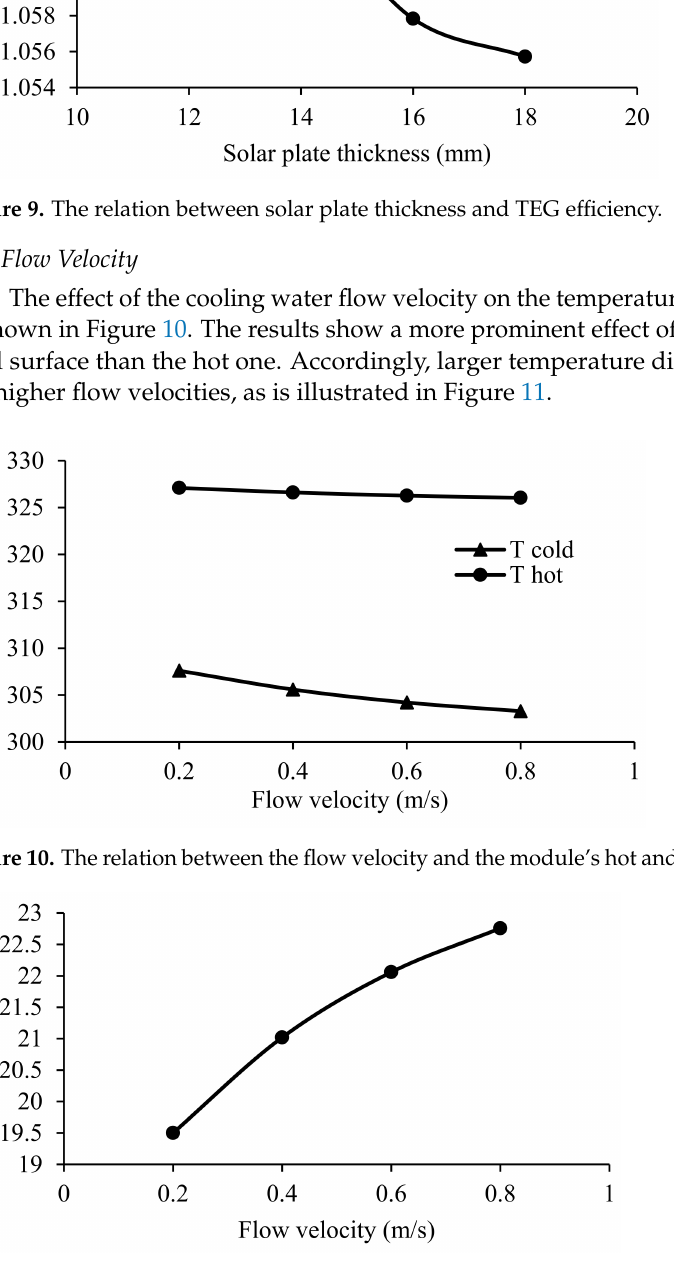
Figure 11. The effect of flow velocity on the temperature difference between the TEG module’s hot and cold